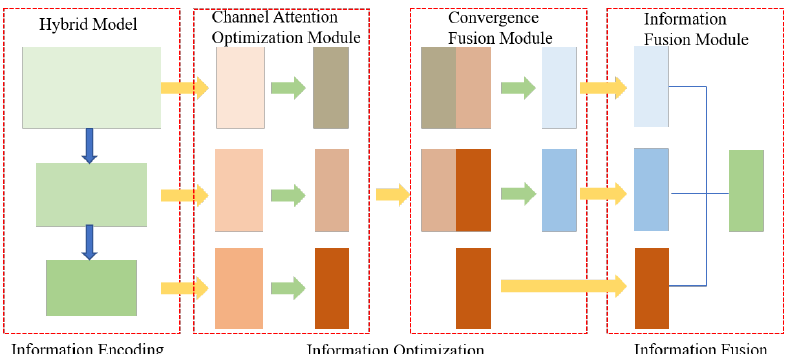
Figure 6. Three steps to decode multiscale semantic information.